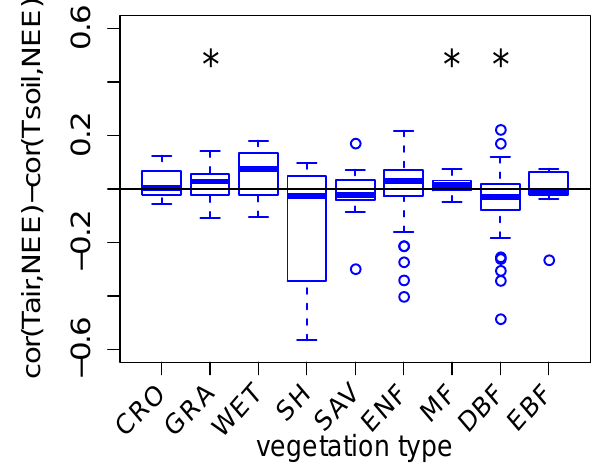
Fig. 6. Differences between the median of significant correlations with air and soil temperature with nighttime NEE for the grow- ing season of one year across FLUXNET sites for different vege- land. The asterisk indicates